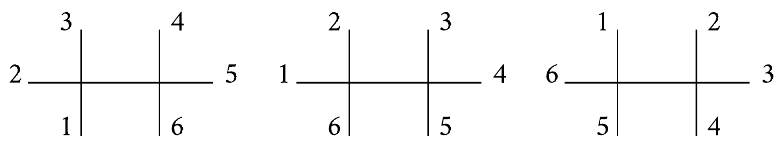
Figure 2 . The factorization diagrams for the ordered 6pt